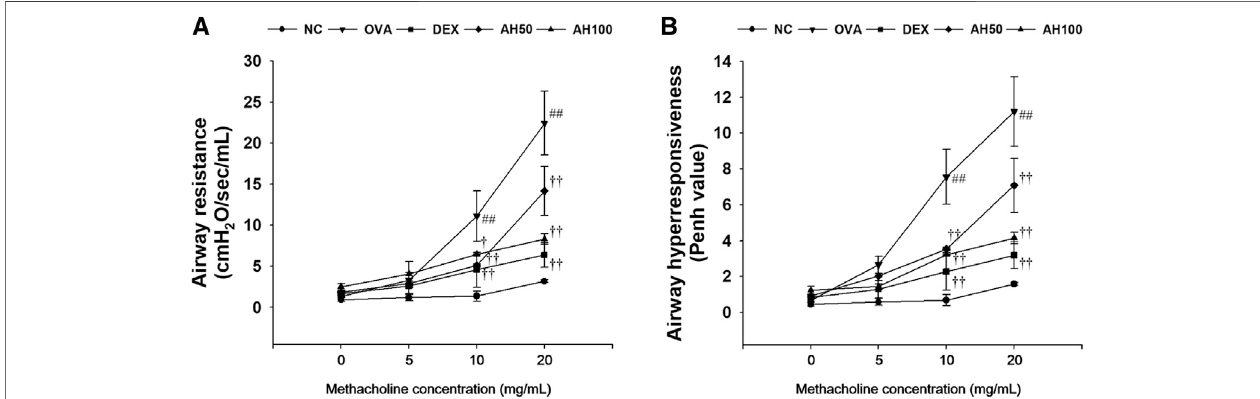
FIGURE 2 | AH attenuates (A) airway resistance and (B) airway hyperresponsiveness in mice 24 h after fi nal OVA challenge. NC: normal control mice; OVA: OVA- challengedmice;DEX:dexamethasone(3 mg/kg)+OVA-challengedmice;AH:AH(50or100 mg/kg)+OVA-challengedmice.Thevaluesareexpressedasthemeans ± SD (n (cid:2) 7/group). ## p < 0.01, signi fi cantly different from NC group; † , †† p < 0.05, p < 0.01, signi fi cantly different from OVA-challenged